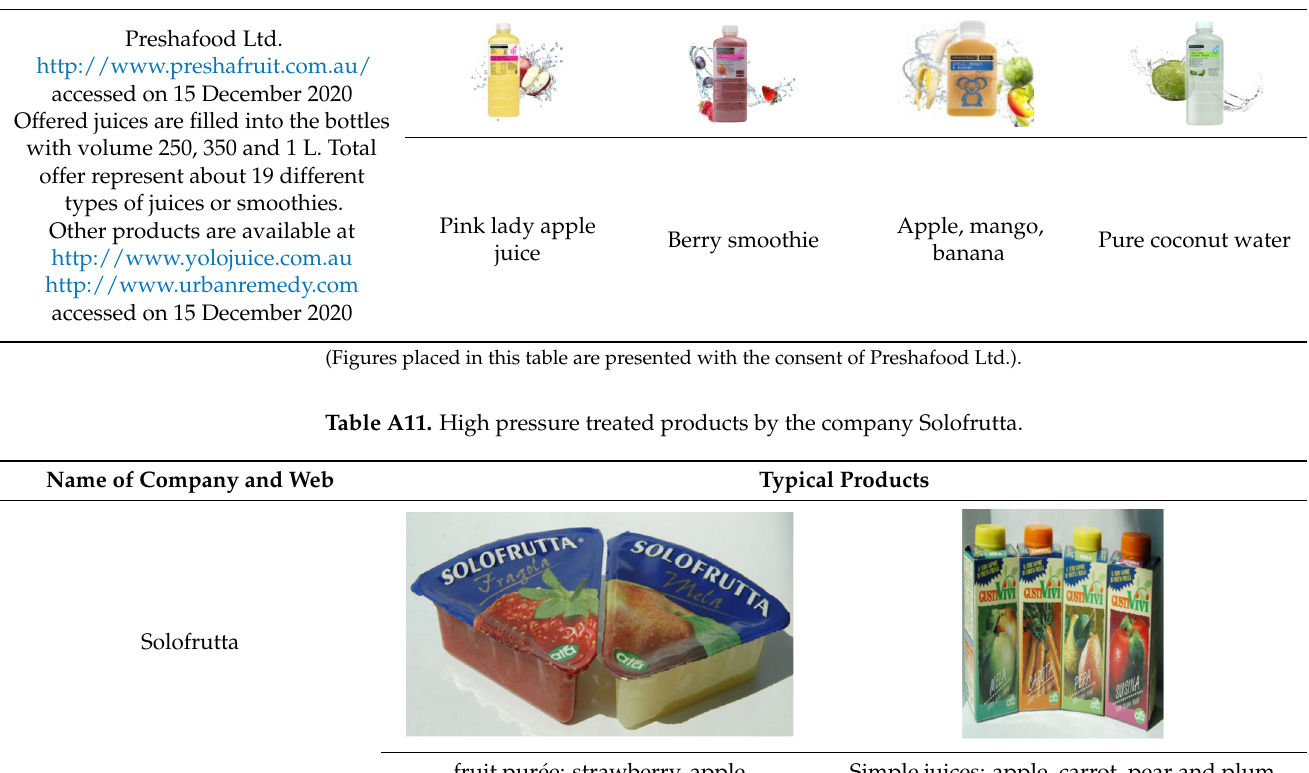
Table A10. High pressure treated products by the company Preshafood. (Figure placed in this table are presented with the consent of Kofola Joint Stock Company).